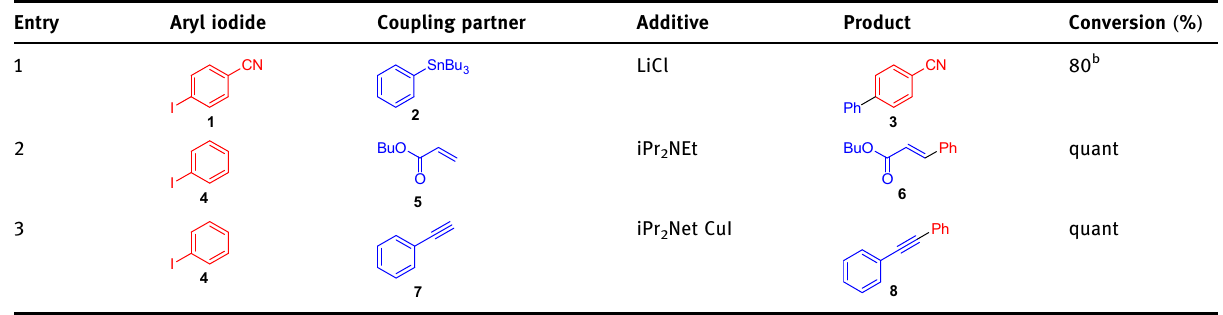
Table 1: Immobilized Pd - catalyzed coupling reactions in batch a